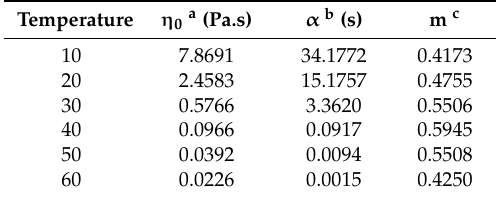
Table 4. Parameters of the Cross model for the range of temperatures